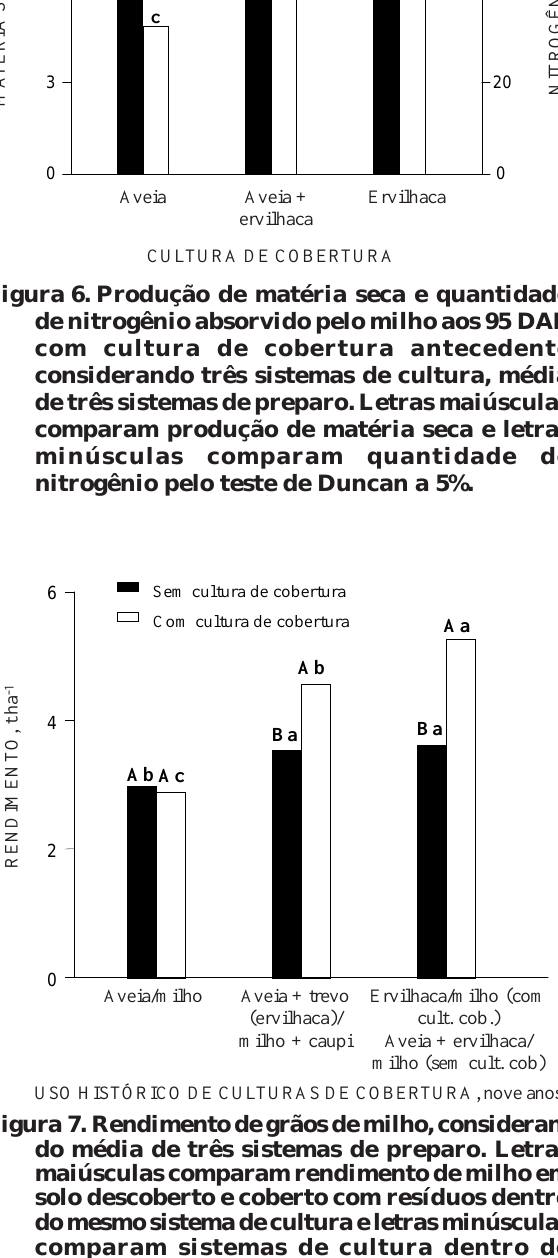
constatado 82% de incremento no rendimento